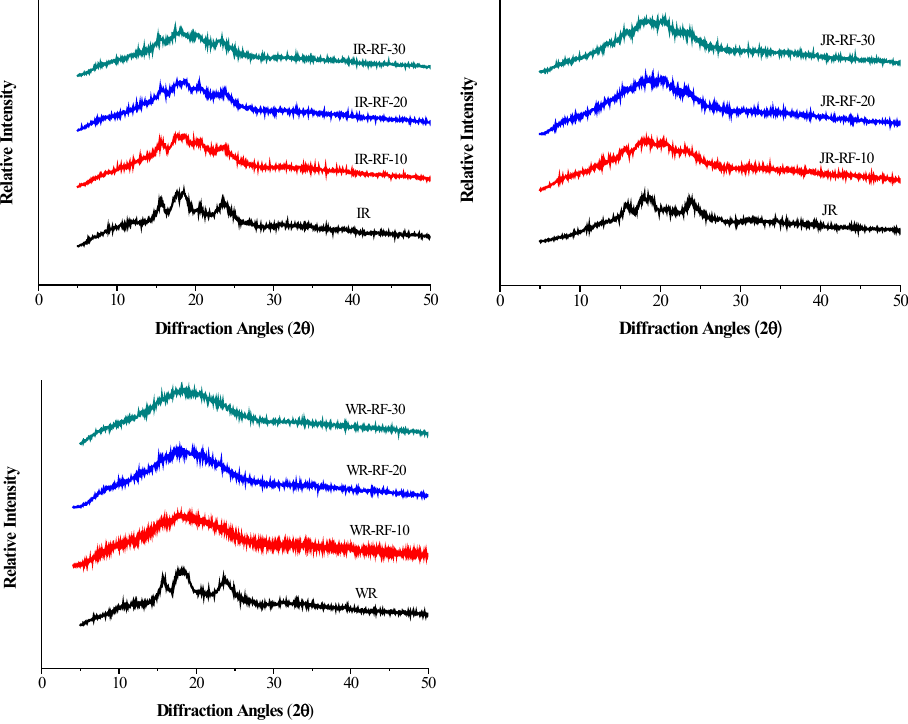
Figure 3. X-ray diffractograms of rice grains were submitted to RF treatment at different times (10, 20, and 30 min). IR: indica rice; JR: japonica rice; WR: waxy rice. Table 1. The X-ray diffraction, FTIR, and thermal characteristics of native and RF-treated rice grains.